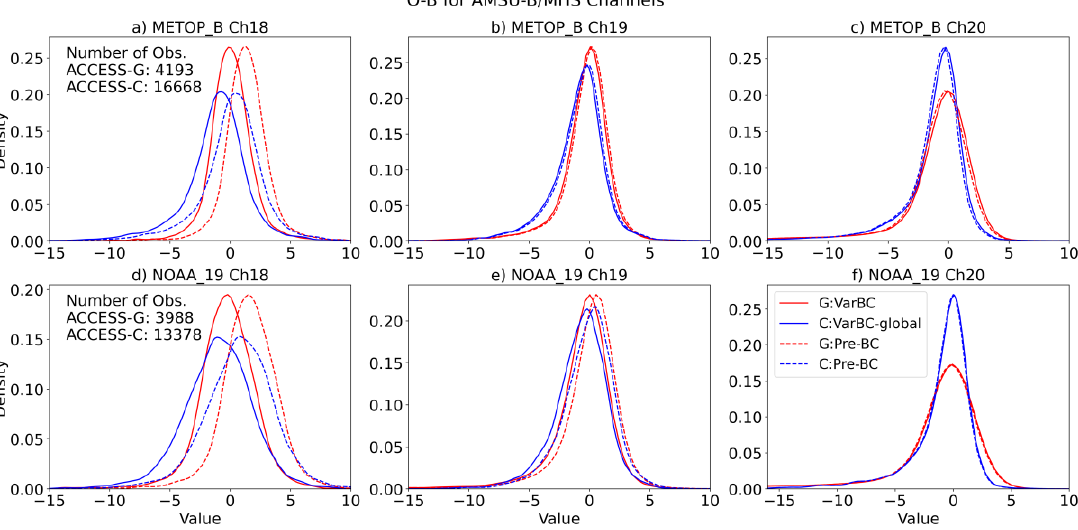
Figure 2. Density function of the observation-minus-background (O-B) differences for channels 18, 19, and 20 of MHS on MetOp-B ( a – c ) and AMSU-B on NOAA-19 ( d – f ) from Experiment 1. The differences are gathered separately for global ACCESS-G (red) and limited-area ACCESS-C (blue) when using the VarBC-global model set-up during Feb 2020. Dashed lines indicate the O-B of ACCESS-G and ACCESS-C without bias correction.